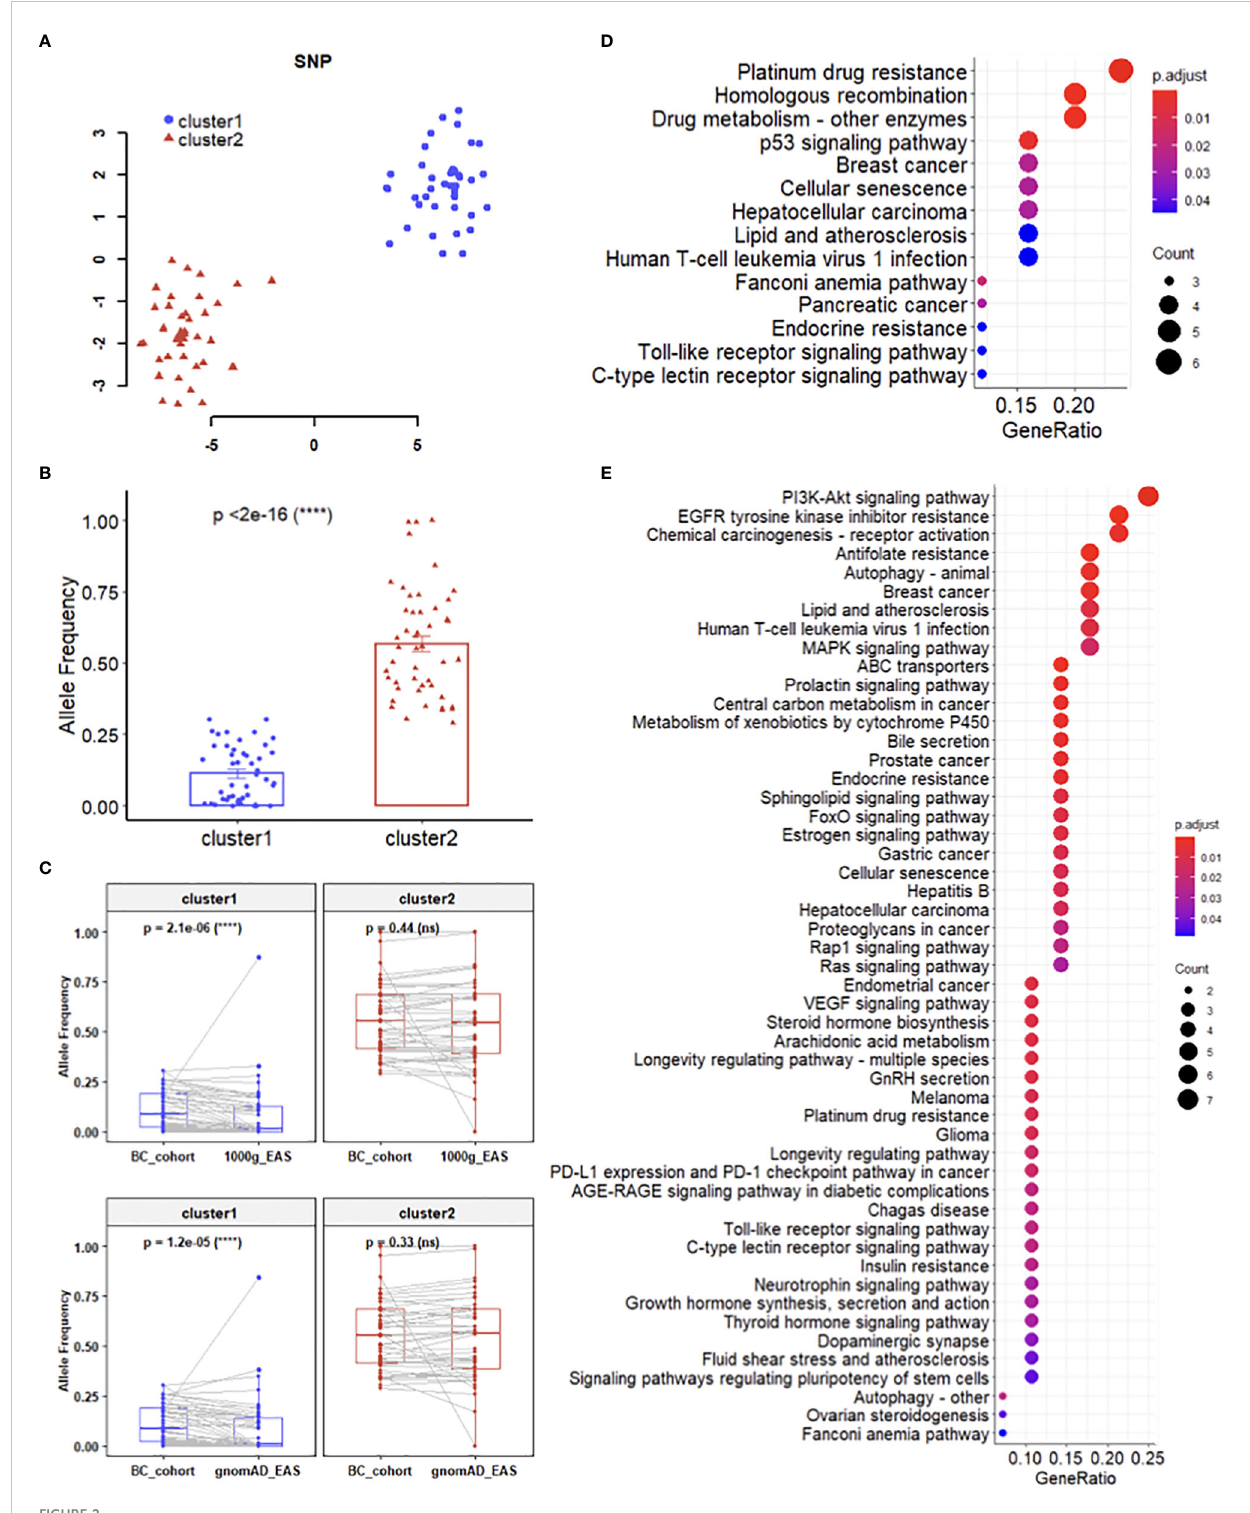
FIGURE 2 Mutation features of SNP clusFters. (A) Dimensionality reduction and clustering of 96 SNPs. (B) Difference between the AFs of SNPs from cluster 1 and cluster 2. (C) Difference between the AFs of SNPs in breast cancer cohort and healthy cohorts. (D, E) KEGG pathway enrichment analysis for cluster 1 (D) and cluster 2 (E) ,